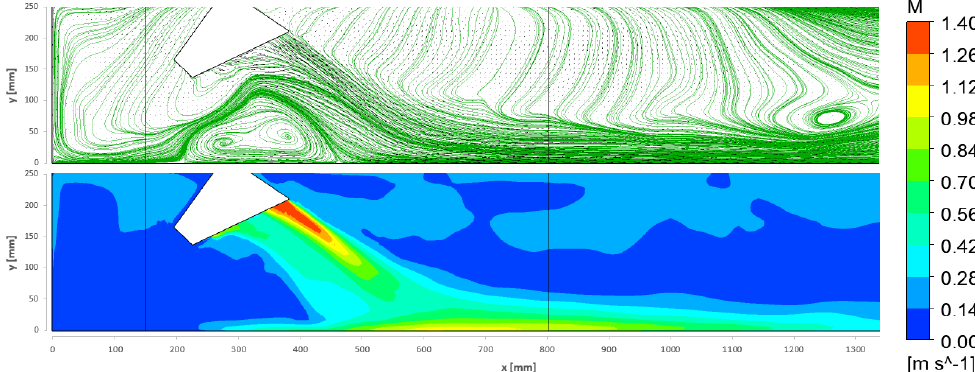
Figure 16. Finite volume method (SAS model), vector lines ( top ) and the magnitude of time-averaged 2D velocity ( bottom ) in vertical plane ( z = − 75mm )